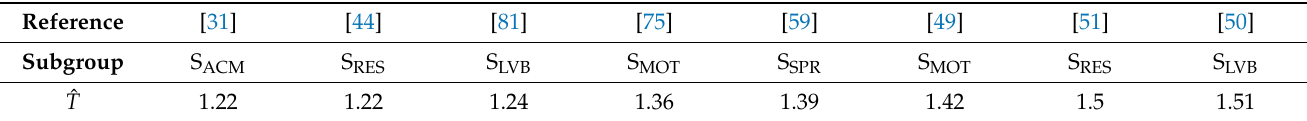
Figure 7. Plots of the normalized total ratings of all studies included in the subgroup analysis. On the left , the ratings, sorted in increasing order, are displayed as points. On the right , the corresponding box plot with the same points are overlaid. Points that correspond to ratings greater than the upper quartile selection threshold ( 𝑄 3 = 1.1 ) are colored red. Table 7. The selected studies, their subgroups, and normalized total